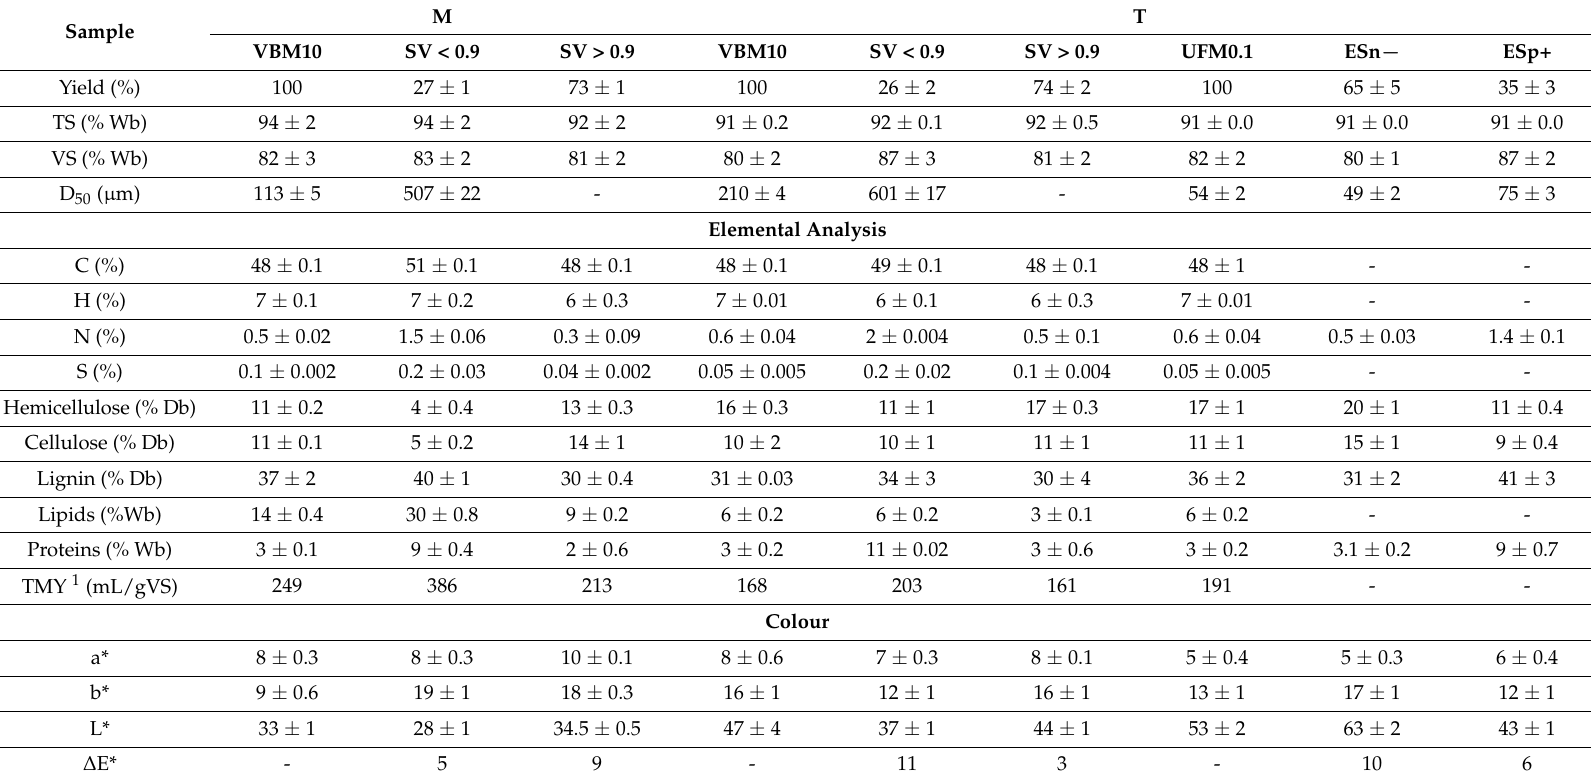
Table 1. Properties of different olive pomaces and their